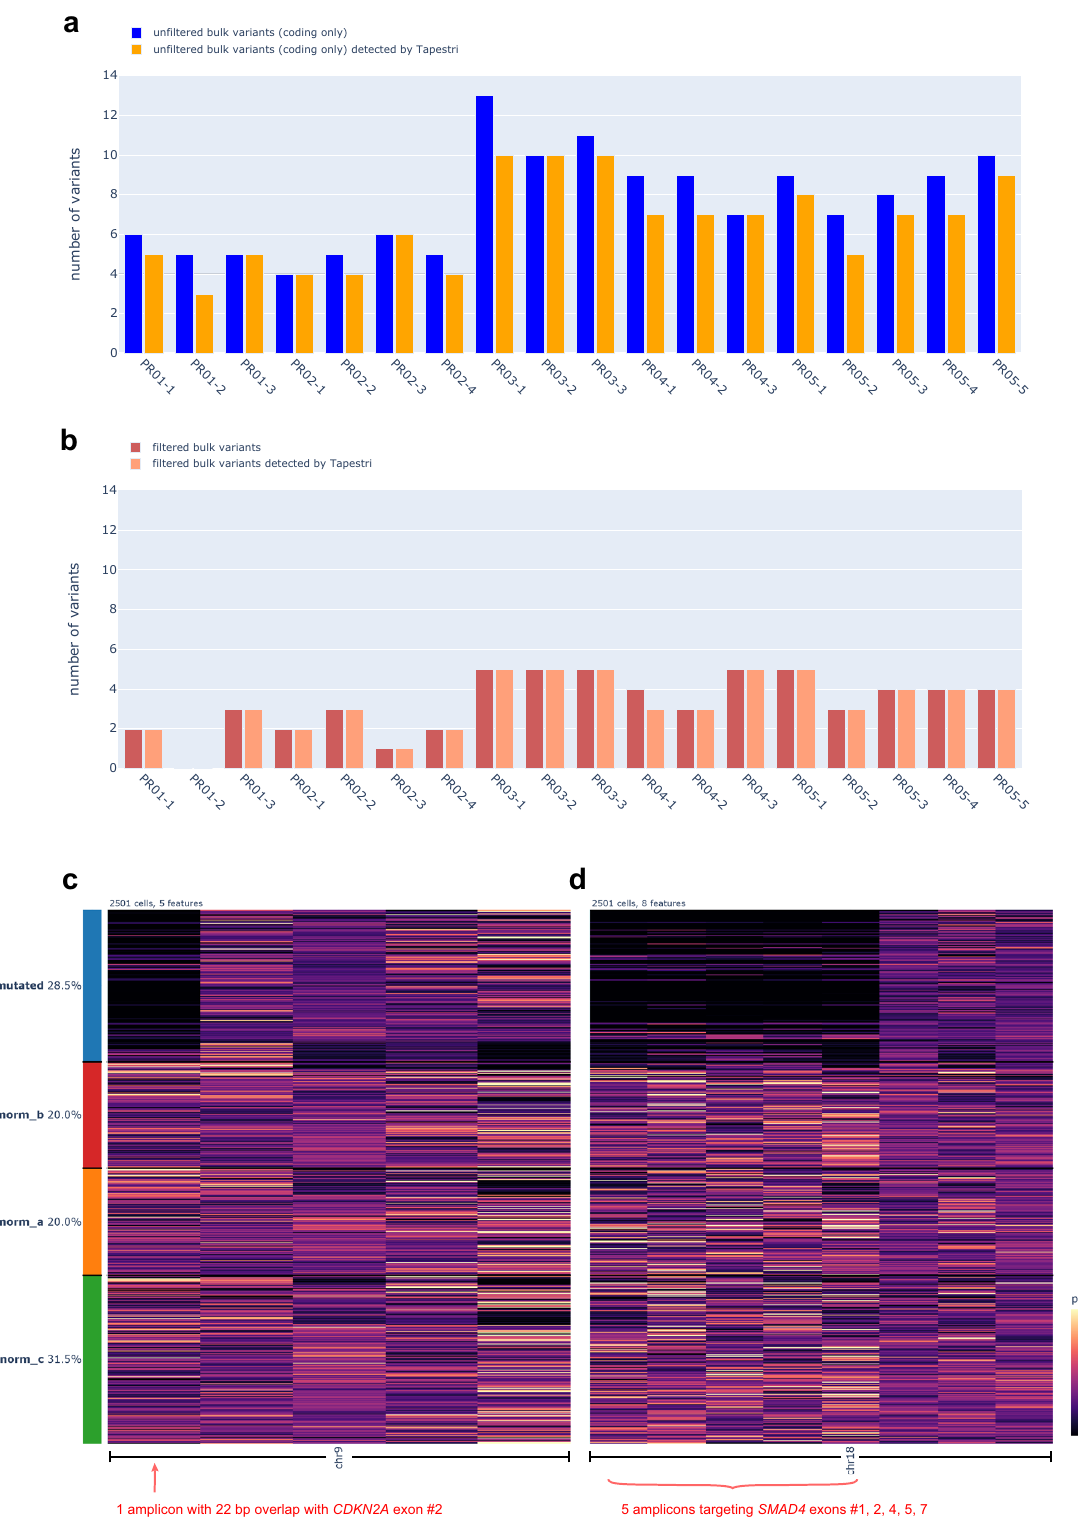
Fig.2|SnDNA-seqcancaptureSNVandCNVpre-identi fi edbybulk-sequencing with high sensitivity. a For 18 samples of the same bulk WES sequencing cohort, histogramshowingthenumberofun fi ltered( “ Methods ” ),codingvariantscalledby bulk (blue) and among them, the number detected by snDNA-seq (orange). b For the same samples, histogram showing the number of fi ltered ( “ Methods ” ) variants called by bulk (dark red) and among them, the number detected by snDNA-seq